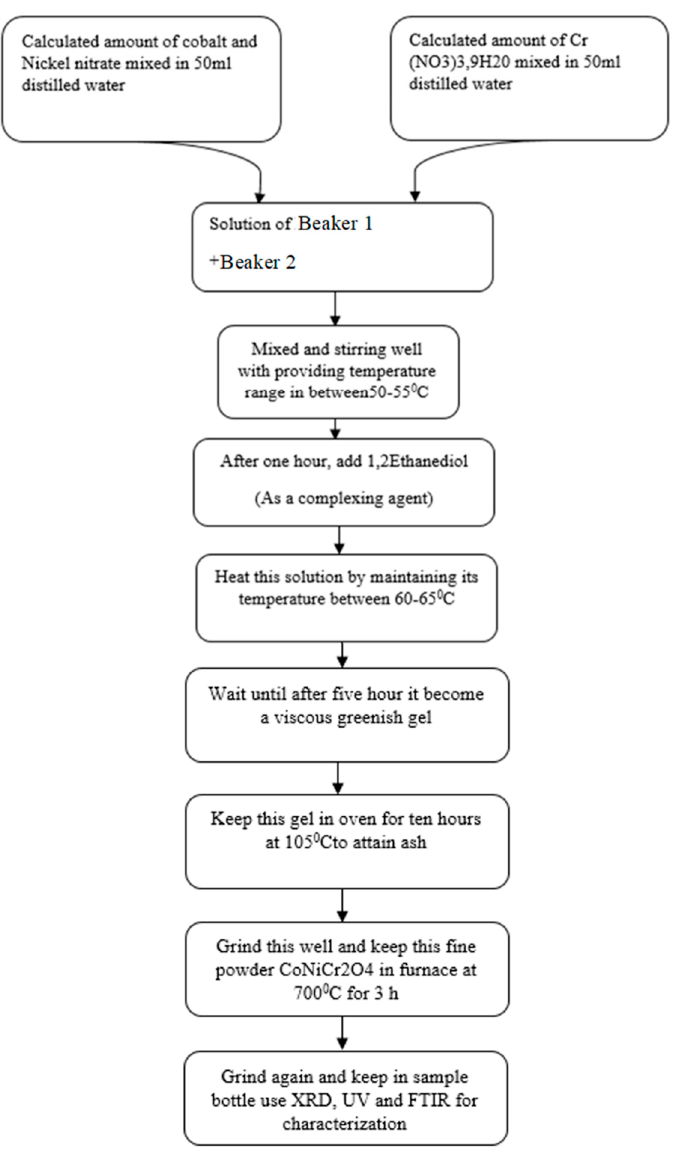
Figure 1. Schematic flowchart of manufacturing CoCr 2 O 4 , CoNiCr 2 O 4 nanoparticle .